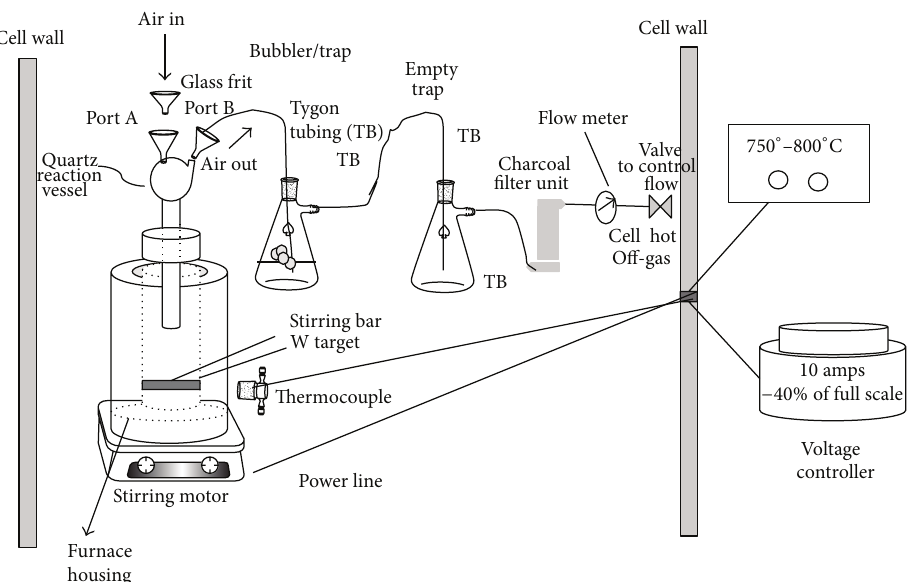
Figure 3: Apparatus used at ORNL for postirradiation conversion of metallic enriched 186 W targets to tungsten oxide